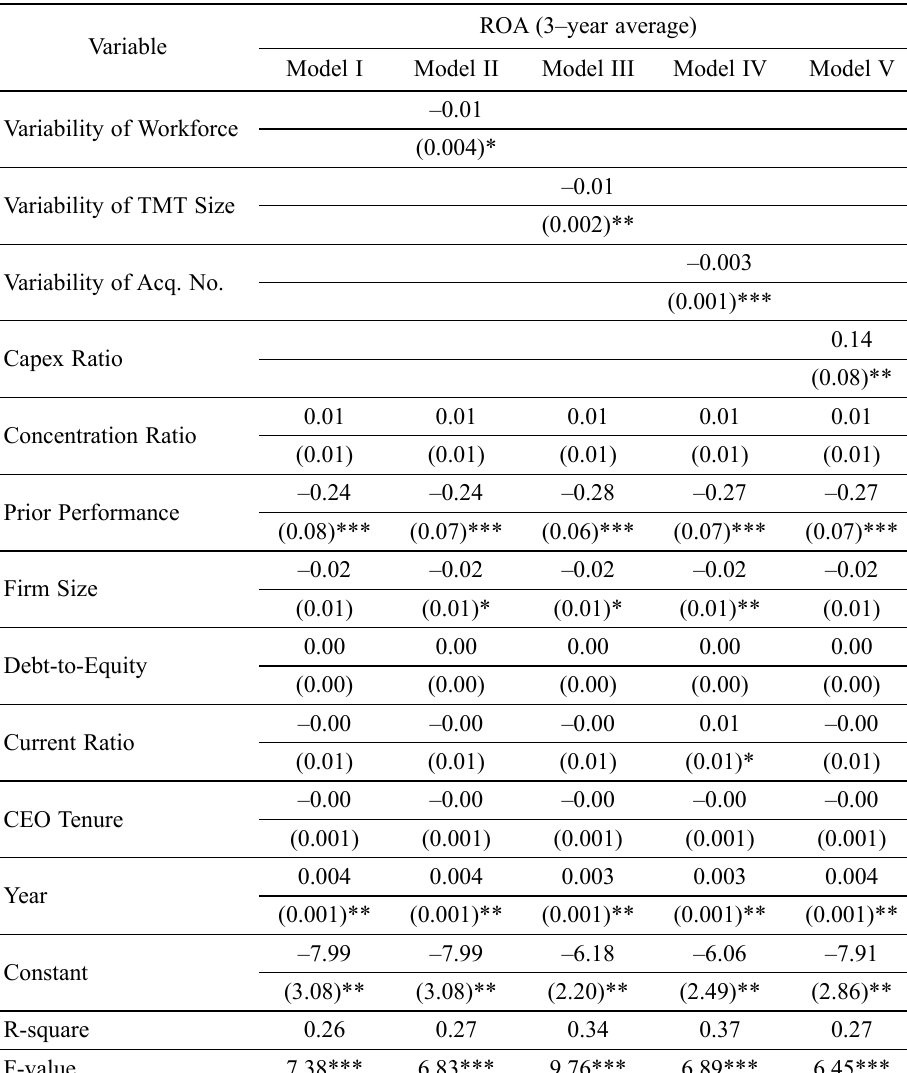
Table 2. Predictor variables regressed on medium-term financial performance (3–year